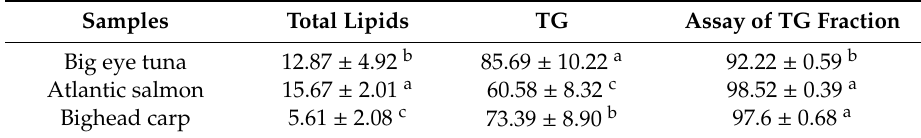
Table 1. The lipids contents and determination of TG fraction in three kinds of fish heads. (%, mean ± S.D., n =